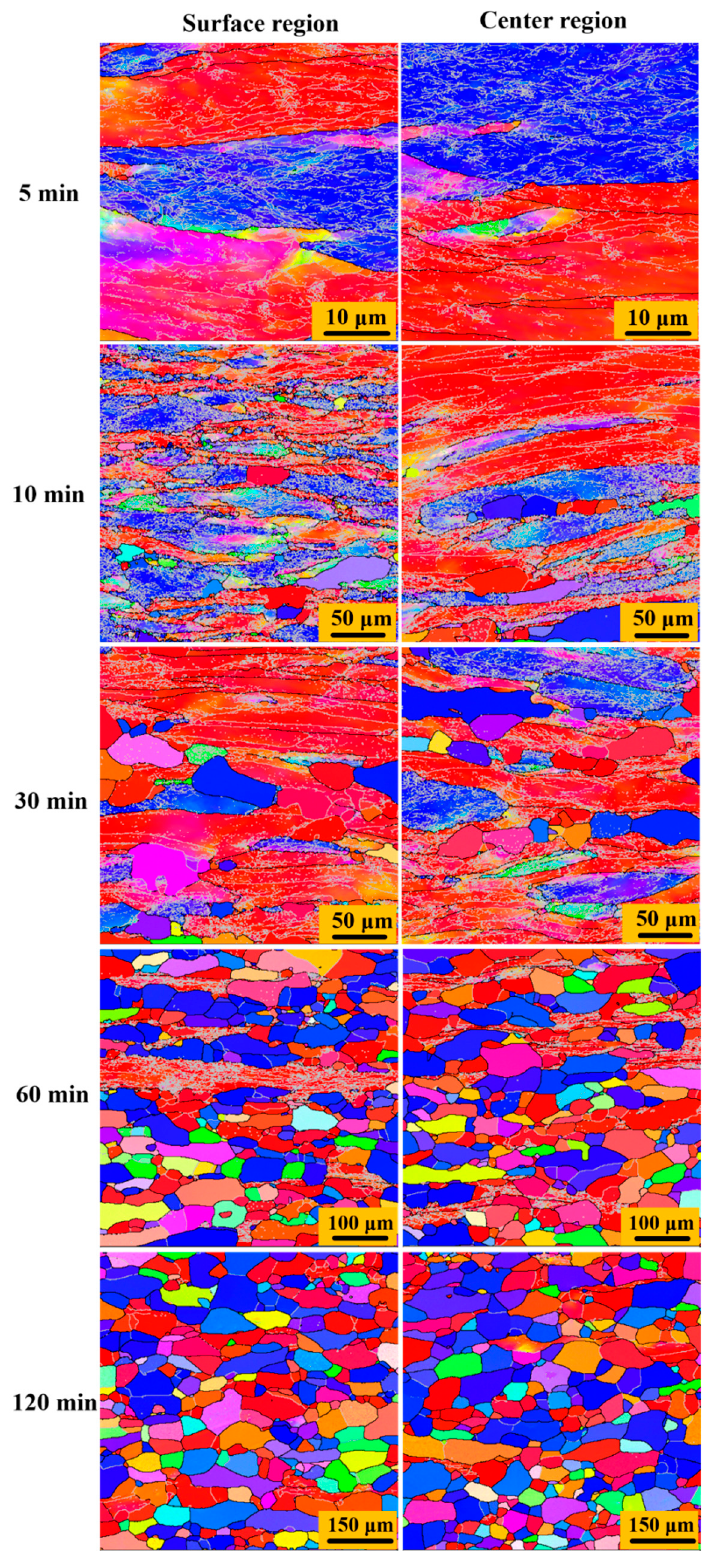
Figure 8. The evolution of the microstructure of the 87% CR sample annealed for different times at 1065 °C. Step size 0.1 μ m for 5 min, step size 0.6 μ m for 10 min and 30 min, step size 1.5 μ m for 60 min and 120 min.